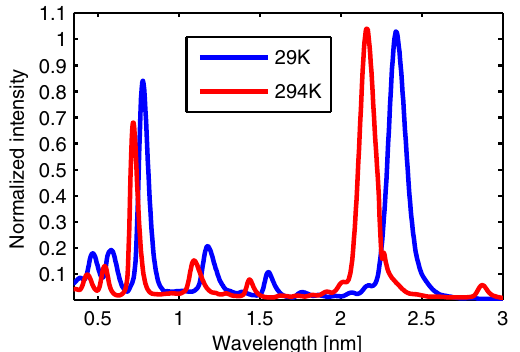
FIG. 6. Lineouts made at the center of the CCD images (observation angle ¼ 0 rad, Fig. 5) of the cold (blue) and the warm (red) case. The absolute flux is not comparable since the entrance slits of the spectrometer are not the same in both cases. From these lineouts the bandwidth of the harmonics are deter- mined and compared to the expected values, to examine a possible increase of field errors due to the temperature drop. The resulting bandwidths are given in Table IV. Both spectra show small peaks at two-thirds of the fundamental wavelength. These features are the third undulator harmonic diffracted into the gratings second order.